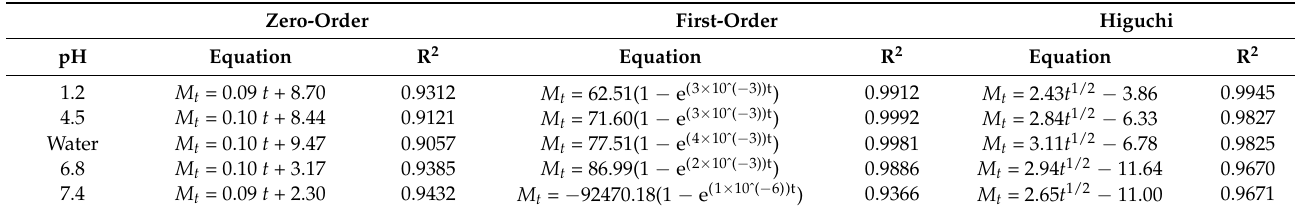
Table 1. Model simulated for the release profiles of microspheres within 0–12